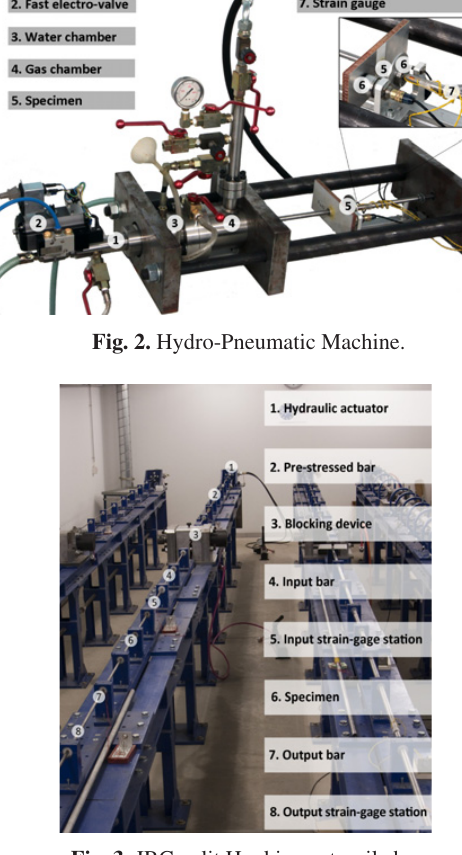
Fig. 3. JRC-split Hopkinson tensile